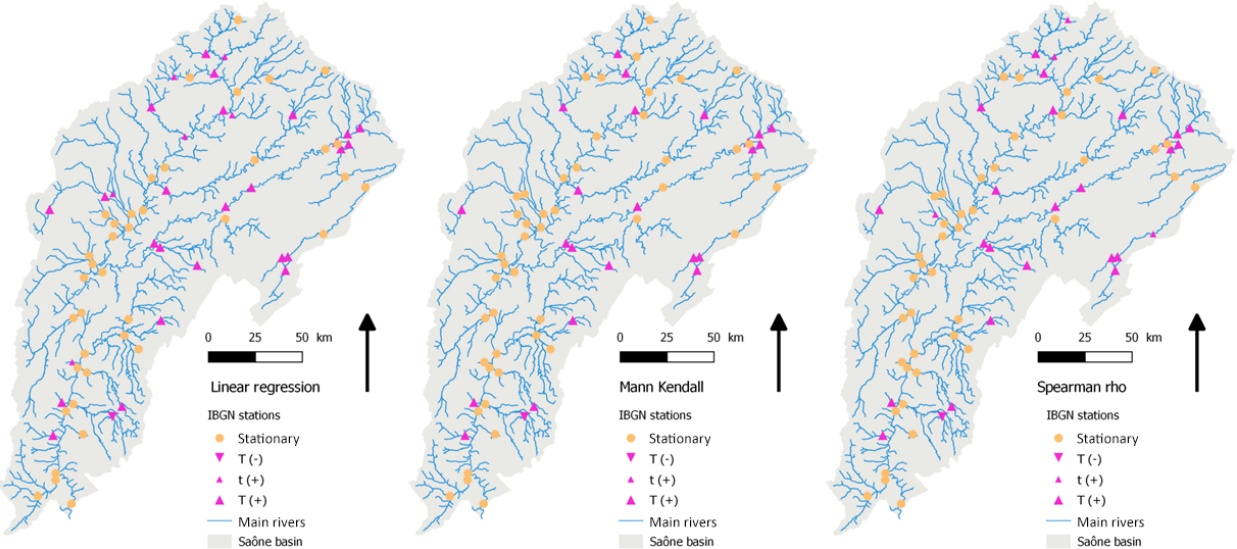
Figure 2. Detected trends for the 71 IBGN series (statistical tests and FDR correction). Stationary, t( + ), t( − ) stands for: stable, positive and negative trend respectively. The use of the capital letter “T” instead of the “t” means the test results remains significant after the FDR